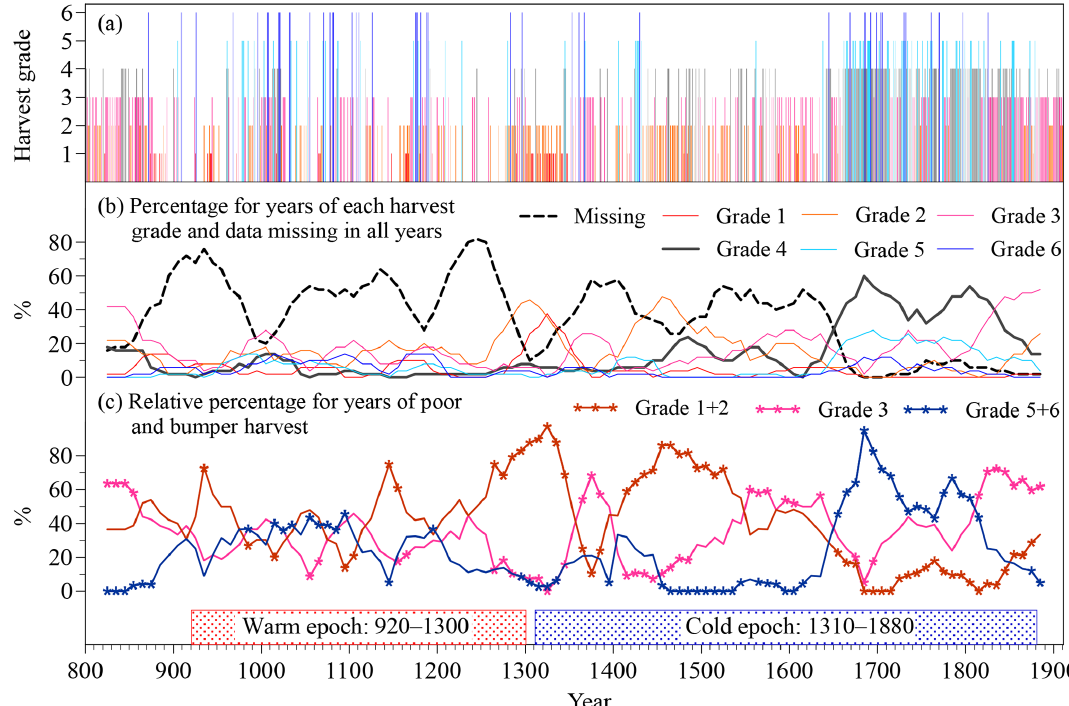
Figure 4. (a) The reconstructed yearly harvest grade from 801–1910 are as follows: 1 – very poor (red), 2 – poor (orange), 3 – slightly poor (pink), 4 – average (black), 5 – near-bumper (light blue), and 6 – bumper (blue). (b) The variation in percentage for the years with each harvest grade and missing data, using a moving window of 50 years with a decadal step. (c) Relative percentage for years of poor (grade 1 + 2), slightly poor (grade 3), and bumper (grade 5 + 6) harvest compared with total years, excluding average harvests and missing data years, using a moving window of 50 years with a decadal step. Stars: intervals with a significantly higher or lower percentage compared with all other intervals, using the Wilcoxon rank sum test. Boxes: the warm and cold epochs identified from the temperature reconstruction for all of China, shown in Fig.